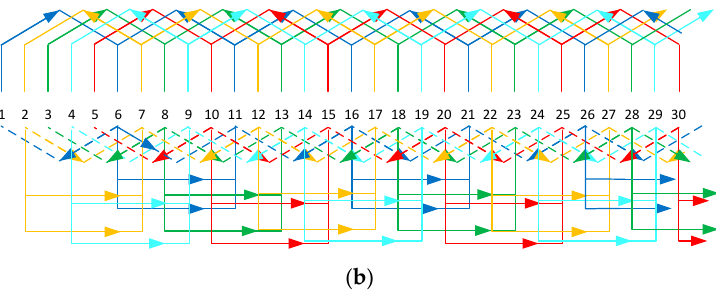
Figure 1. FEM model of the analyzed machine. ( a ) Layout of the machine. ( b ) Half winding of the five-phase 60-slots machine with a double layer and constant pitch with q = 1.